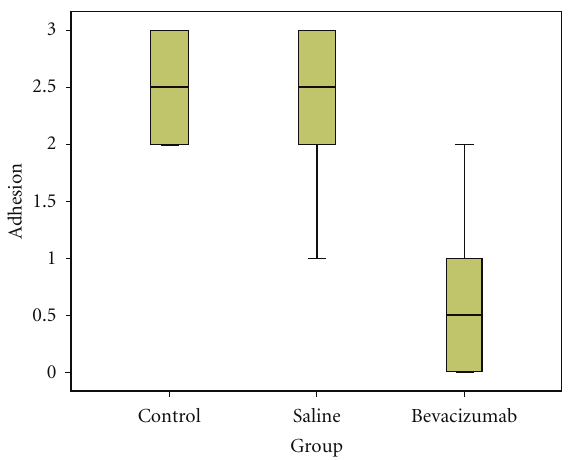
Figure 3: The bevacizumab group had a significantly lower ad- hesion grades.